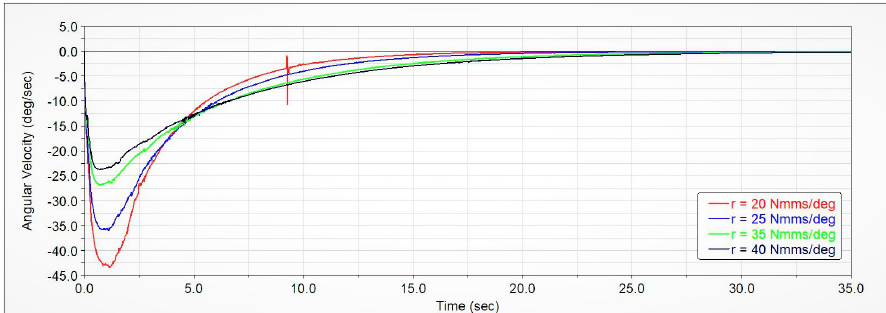
Figure 12. Spring-damper system time-rate angle of the first cell as a function of the simulation time and when the damping coefficient of the damper varies from 20 to 40 N · mm · s/deg.